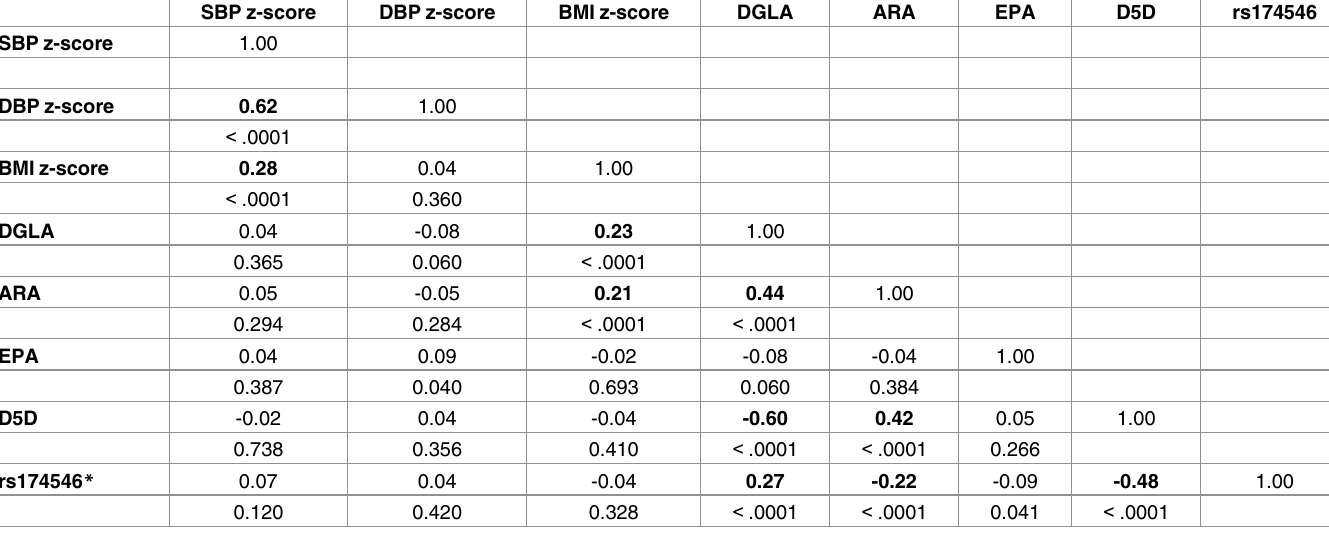
Table 3. Pearson correlation coefficients and p-values among SBP, DBP, BMI z-score, FA and D5D index and the SNP. SBP